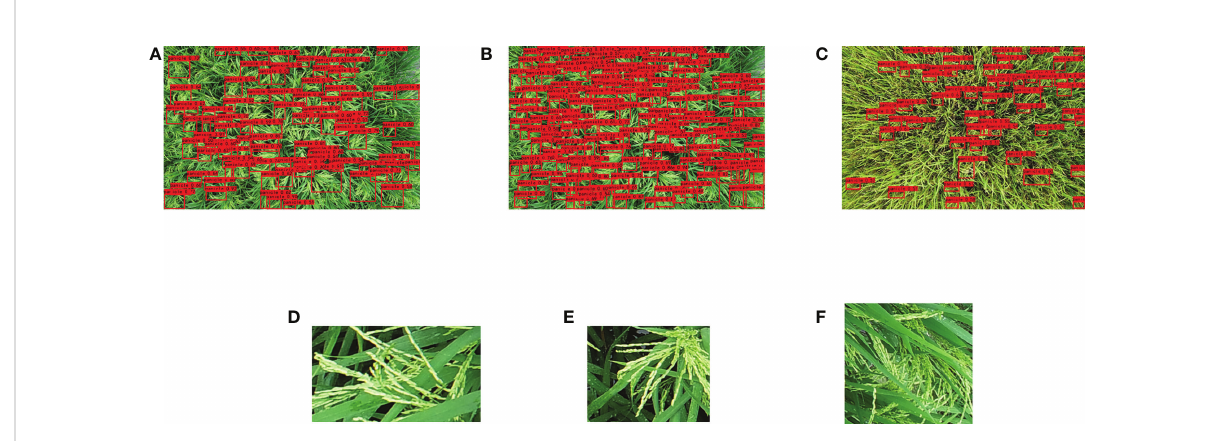
FIGURE 9 Recognition results of UAV images using the large-scale dispersion spike model. (A) Recognition results of the original YOLOv4 model, and (B) Recognition results of the improved algorithm (C) Improved algorithm recognition during maturity. (D – F) Large-scale UAV view prediction frame